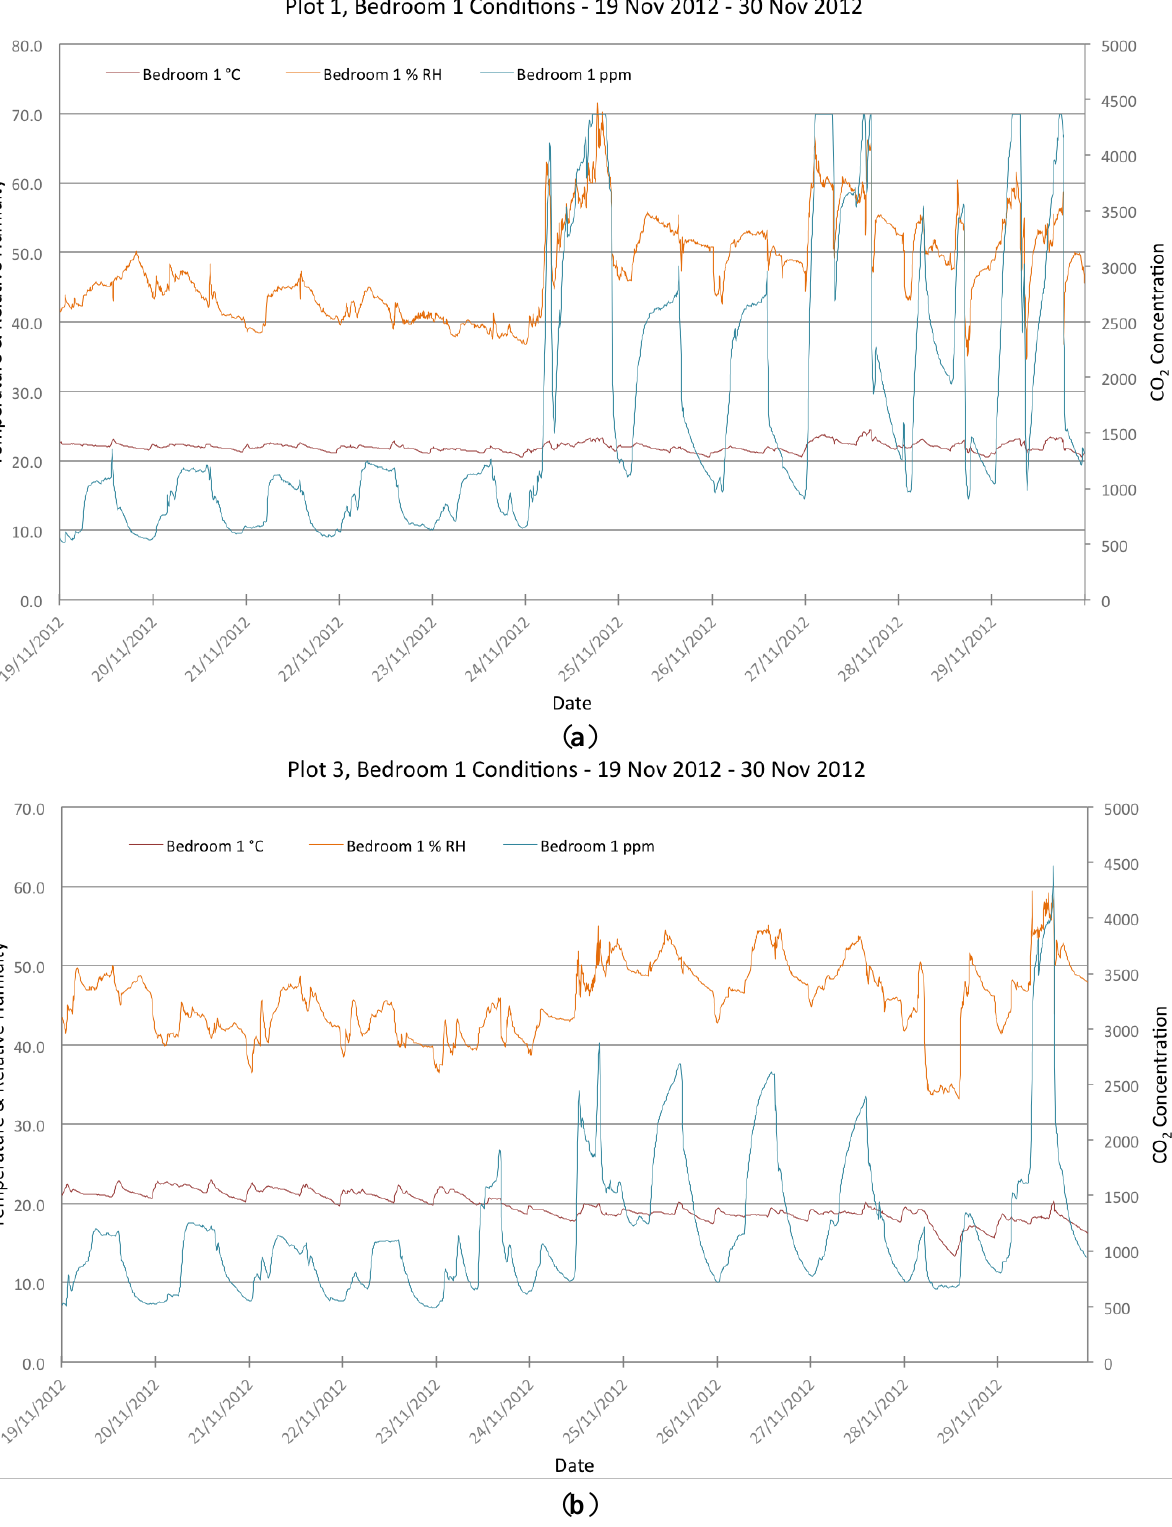
Figure 10. ( a ) CO 2 temp and RH levels SC6, Plot 1, Bedroom 1; ( b ) CO 2 temp and RH levels SC6, Plot 3, Bedroom